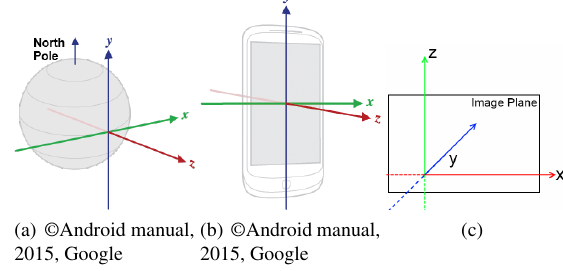
Figure 3: Schematic of coordinate systems defined in the Google Android operating system (a and b) 2 , and the system used later in this article (c).